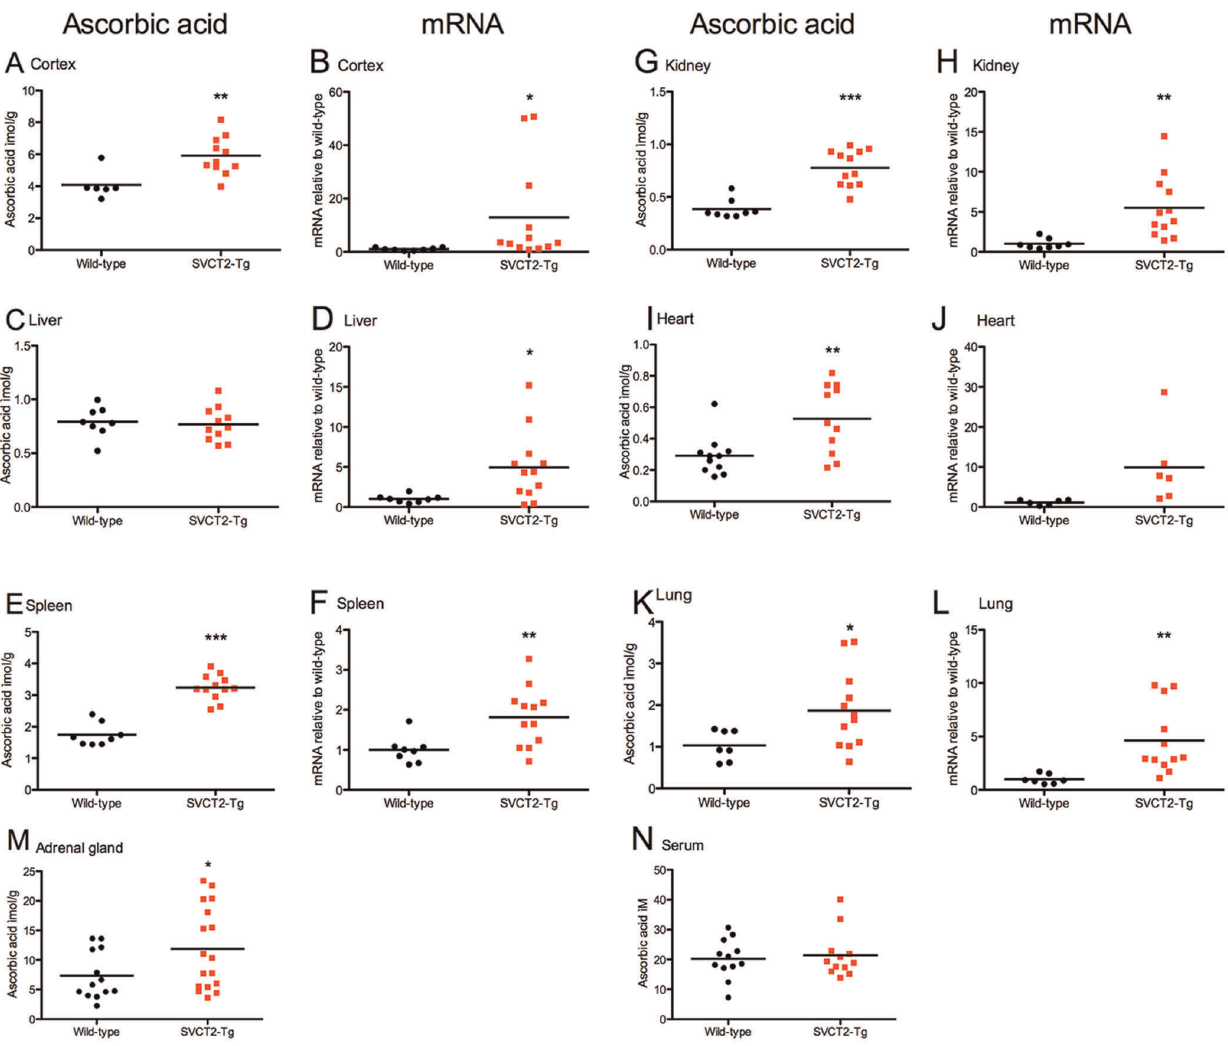
Figure 2. Ascorbic acid and mRNA level in SVCT2-Tg mice. SVCT2-Tg had higher ASC levels in all organs measured except liver, nor did serum ASC vary between groups. (A) cortex, (C) liver, (E) spleen, (G) kidney, (I) heart, (K) lung, (M) adrenal gland, and (N) serum. mRNA signal was increased in all organs measured, although this difference was not significant in heart. (B) cortex, (D) liver, (F) spleen, (H) kidney, (J) heart, (L) lung, (M) adrenal gland, and (N) serum. *, **, *** p , 0.05, 0.01, 0.001 compared to wild-type